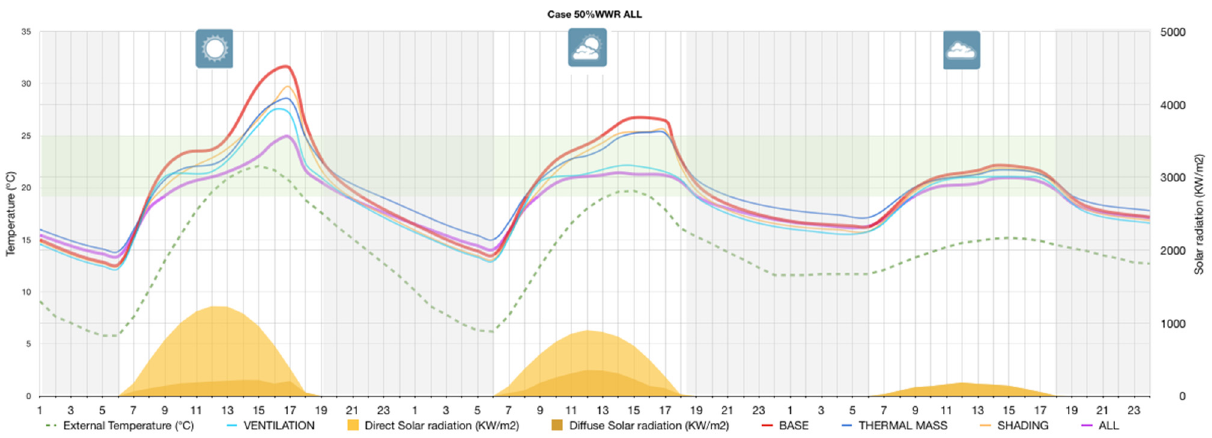
Figure 16. Simulation of thermal performance for the scenario of 50% WWR and four sides exposed to the